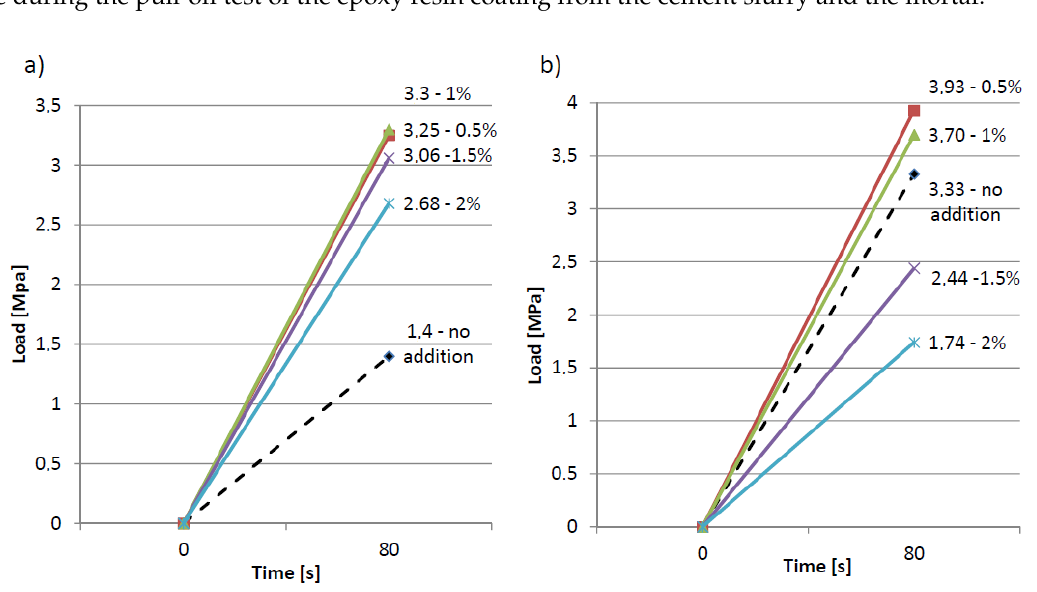
Figure 10. Load rate during the pull-o ff test of the epoxy resin coating from: ( a ) the cement slurry, ( b ) the